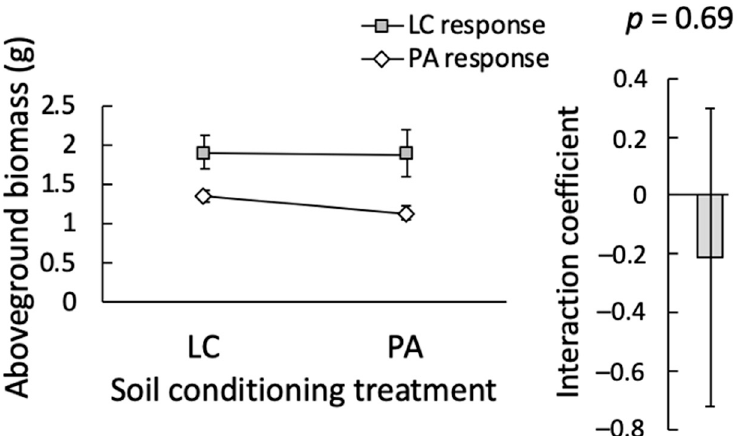
Figure 3. Feedback between Lotus corniculatus (LC) and Phalaris arundinacea (PA). These species experience neutral feedback. Neither species is significantly affected by soil conditioning treatment although P. arundinacea does grow slightly better in soil conditioned by L. corniculatus . The inset shows the interaction coefficient between these species, which does not differ significantly from zero ( p = 0.69), also indicative of neutral feedback. Bars indicate ± SE.